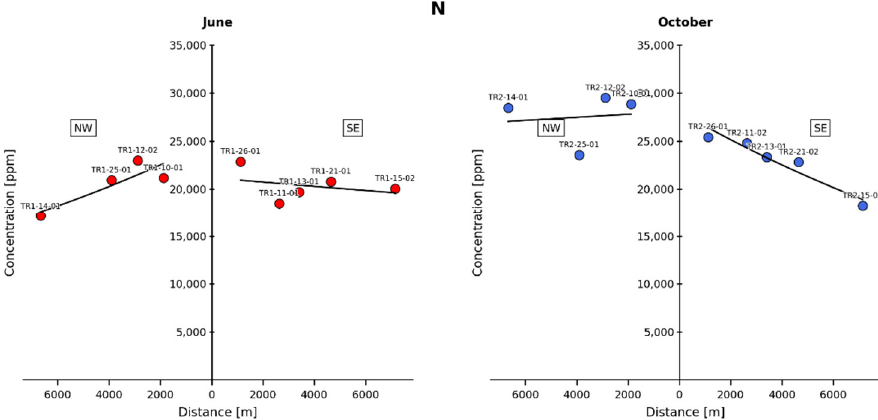
Figure A1. Gradients of concentrations of the assessed elements in terrestrial mosses collected in the surroundings of the Třinec Iron and Steel Works.